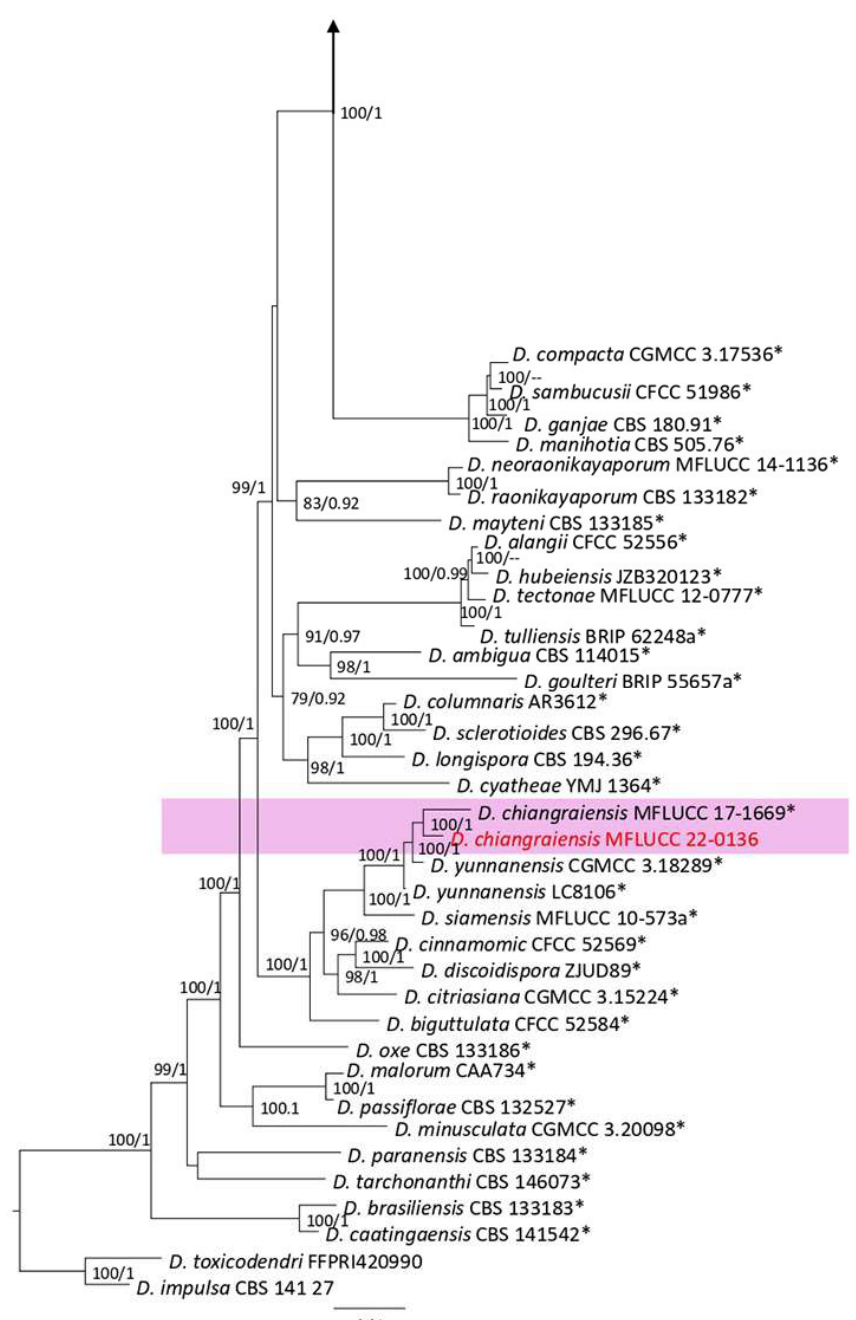
Figure 19. The Diaporthe sojae complex. Bayesian phylogenetic tree obtained from the combined ITS, tef1 , tub2 , cal , and his3 sequence data. The tree was constructed using MrBayes 3.2.7a on CIPRES Science Gateway. The ultrafast maximum likelihood bootstrap support (%) ≥ 50 and BYPP ≥ 0.90 are shown at the nodes. The ex-type strains are marked with an asterisk. The tree is rooted in D. toxicodendri (FFPRI420990) and D. impulse (CBS 141 . 27) .